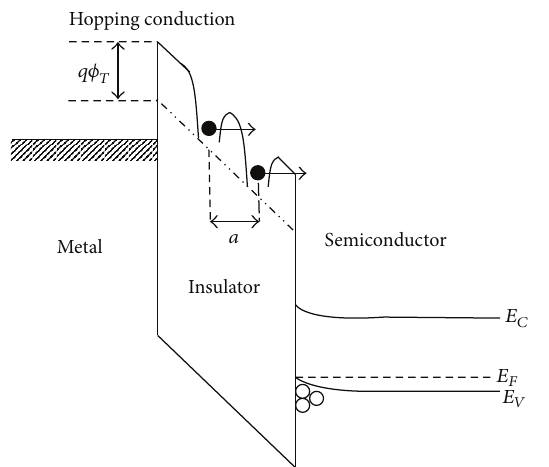
Figure 16: 𝐽 - 𝐸 characteristics and simulation of hopping conduc- tion for a laminated Pr 2 O 3 /SiON MIS capacitors at low electric